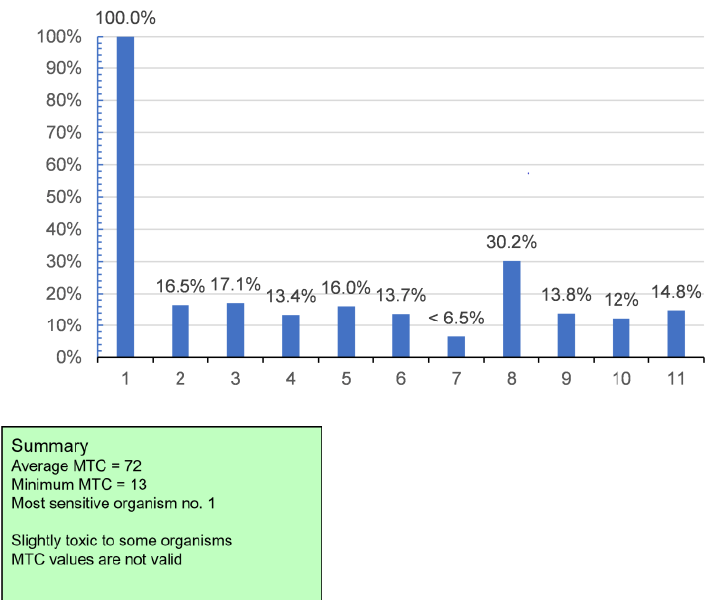
Figure 2. Finger print (FIP) of tested mussel powder, strain with y-axis 100% indicates most sensitive organism (description of 1 to 11—see Table 1).